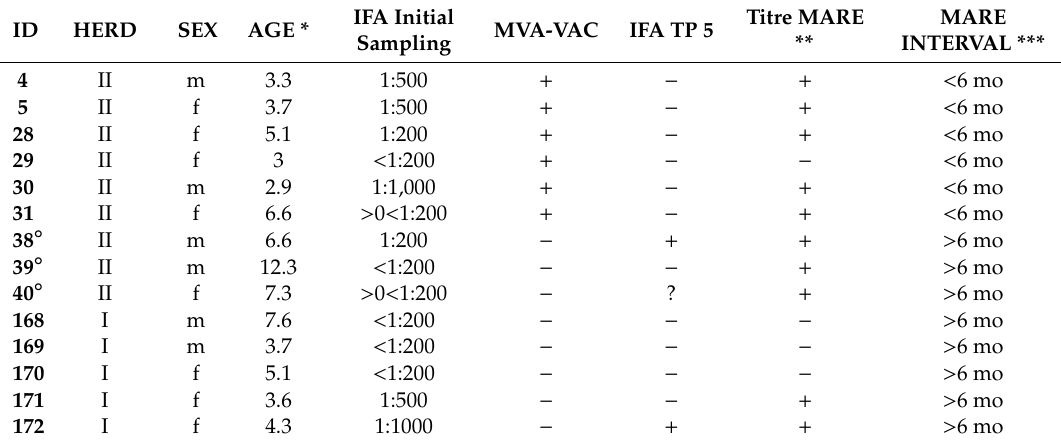
Table 4. Results of antibody testing in 14 crias and their dams as part of a field trial of MVA vaccination of alpacas against cowpox in